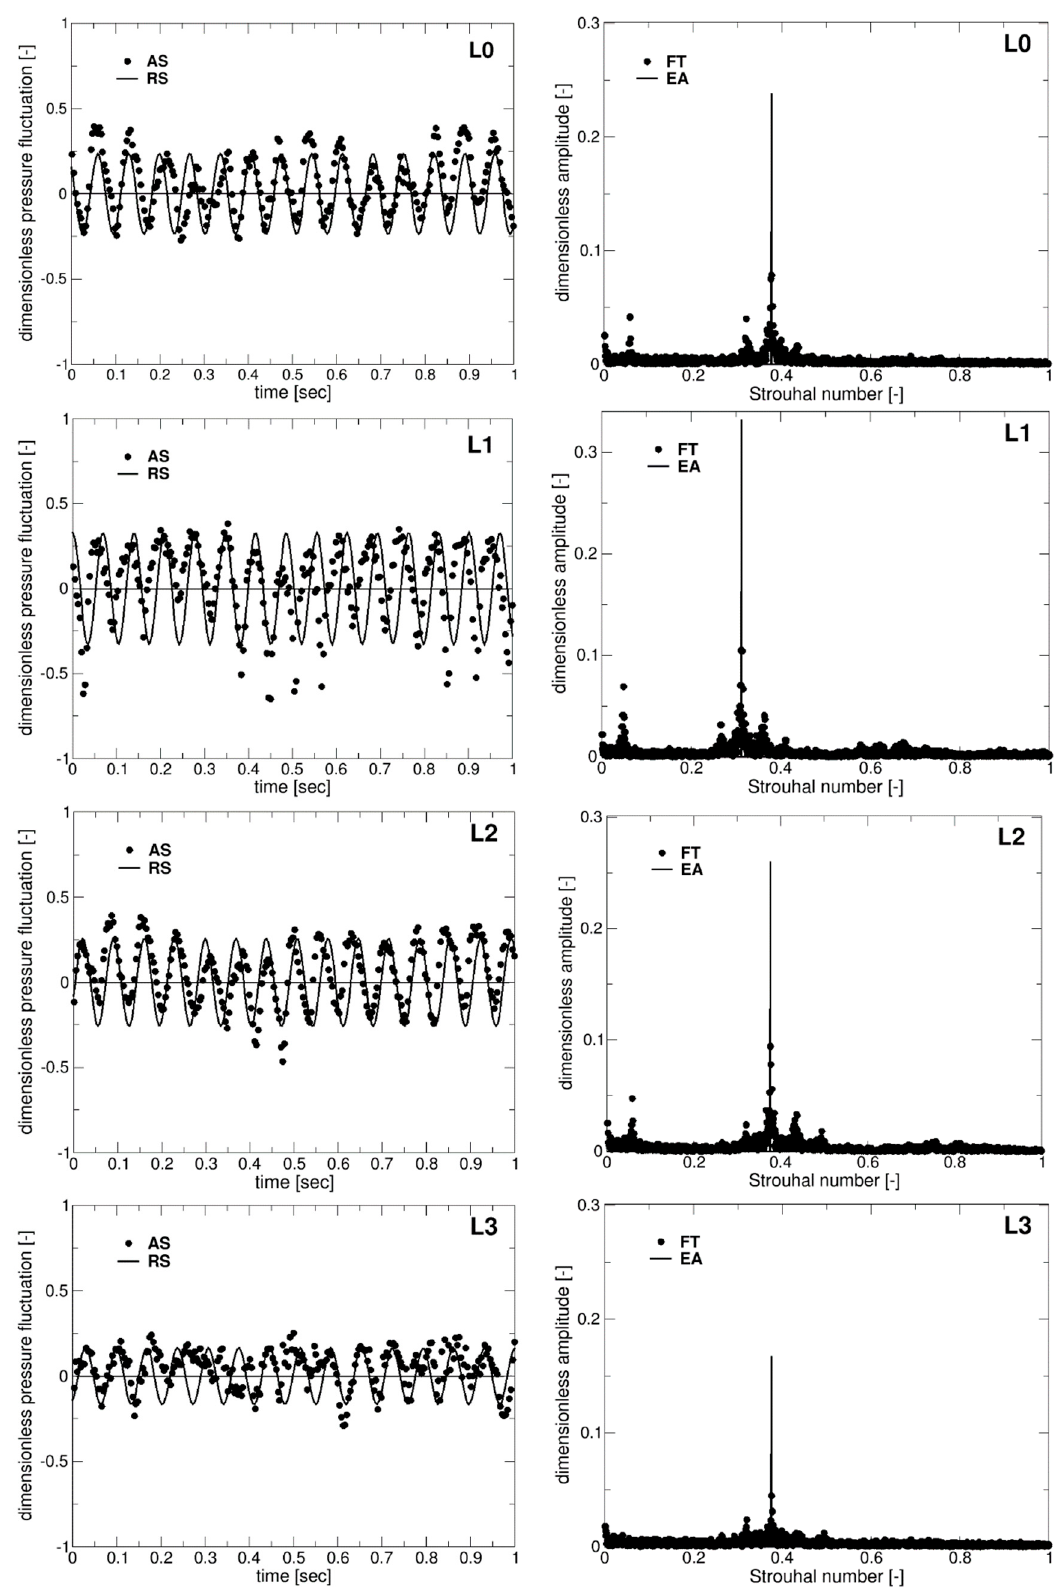
Figure 4. Pressure fluctuations on all levels without diaphragm: acquired signals (AS) vs. reconstructed signals (RS) (left) and it Fourier spectra (FT) vs. equivalent amplitudes (EA) (right).